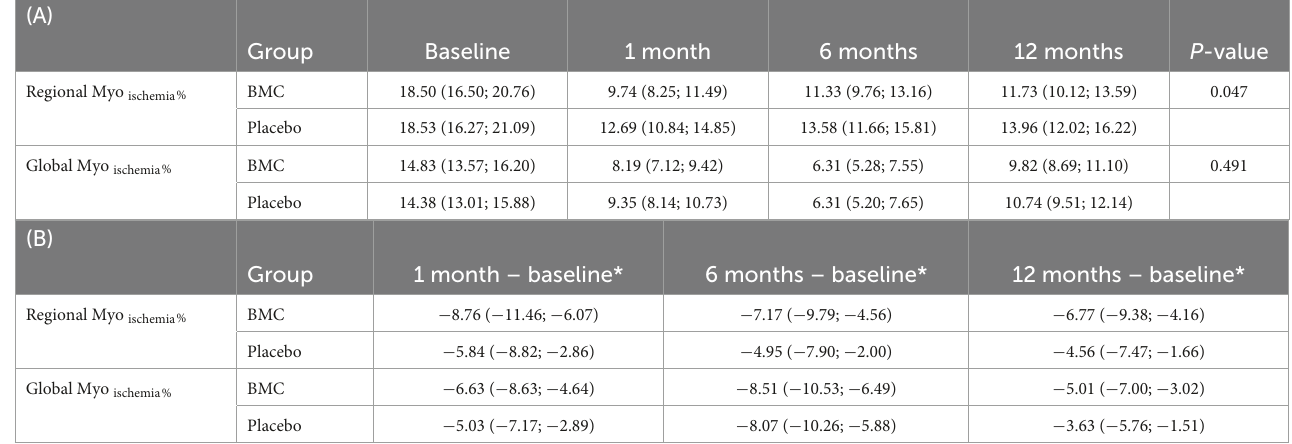
TABLE 2 Effect of BMC on regional and global stress induced myocardial ischemia